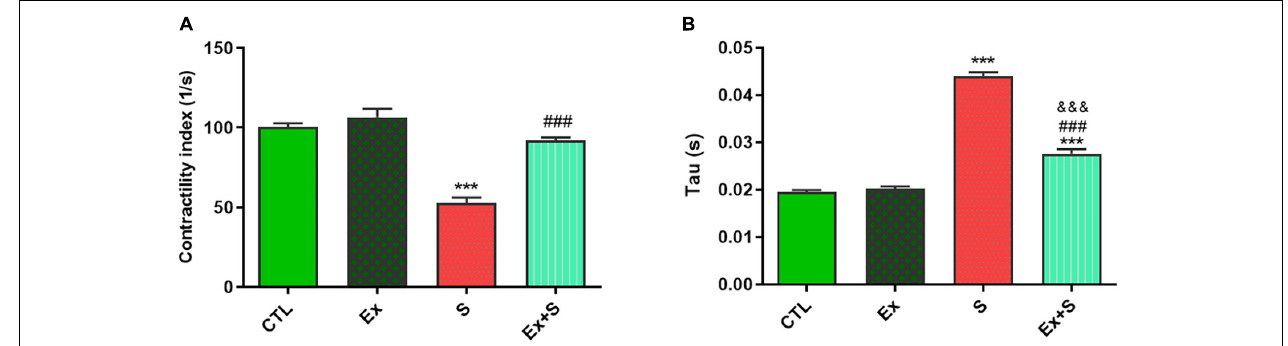
FIGURE 4 | Effects of waterpipe smoke inhalation on contractility index (A) and Tau index (B) in experimental groups. CTL, control group; Ex, group subjected to exercise training for 8 weeks; S, group subjected to waterpipe tobacco smoke inhalation for 8 weeks; Ex + S, group subjected to exercise training and waterpipe tobacco smoke inhalation for 8 weeks. The results are presented as mean ± SEM, n = 7. *** P < 0.001 vs. CTL; ### P < 0.001 vs. S; &&& P < 0.001 vs. Ex.